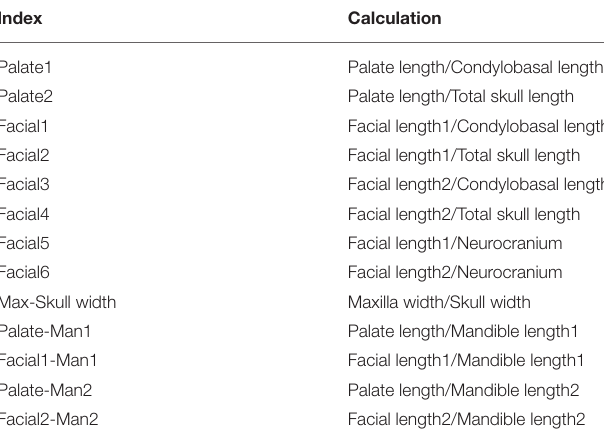
TABLE 3 | Indices calculated for the five cheetah cubs, based on linear skull measurements.